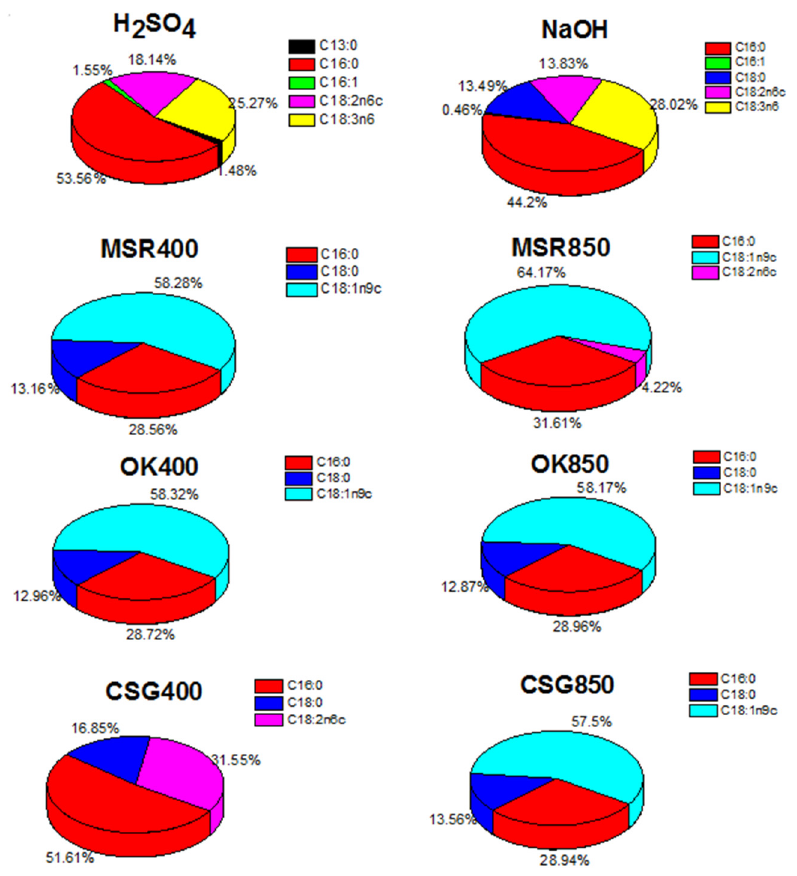
Figure 5. Content of methyl esters produced via H 2 SO 4 , NaOH, and MSR at 400 and 850 °C; OK at 400 and 850 °C; and CSG at 400 and 850 °C.